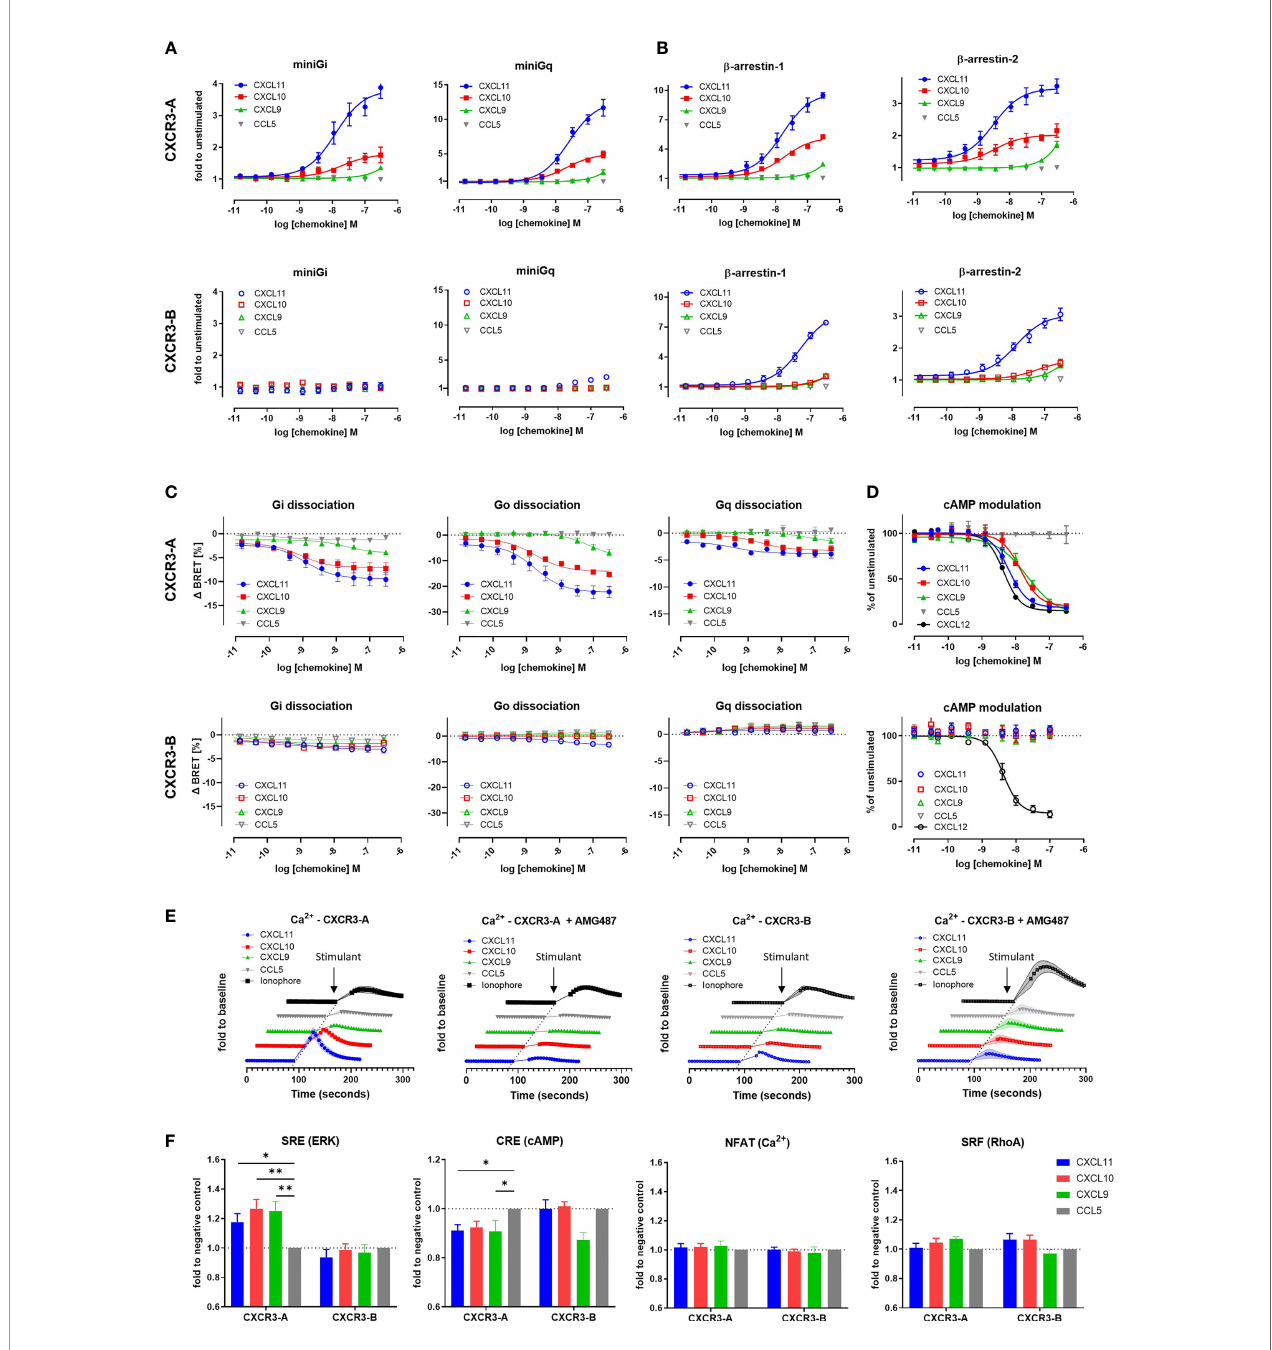
FIGURE 1 | The CXCR3-B isoform does not induce G protein-mediated signaling. (A) miniG protein or (B) b -arrestin recruitment towards CXCR3-A and CXCR3-B in response to CXCL11, CXCL10, CXCL9 and the negative control CCL5 monitored by NanoBiT-based assay. (C) Heterotrimeric G protein dissociation upon CXCR3-A or CXCR3-B stimulation with CXCL11, CXCL10, CXCL9 and CCL5 monitored by NanoBRET. Concentration-response relationships for the alpha subunits G i2 , G o and G q are expressed as D BRET. (D) CXCR3-A- and CXCR3-B-driven reduction of intracellular cAMP levels, in response to chemokine ligands. CXCL12- induced effect mediated by the endogenously expressed CXCR4 was used as positive control. (E) CXCR3-A- and CXCR3-B-mediated intracellular calcium mobilization in response to chemokines in the absence or presence of CXCR3 antagonist AMG487 (1 µM) monitored by NanoBiT assay. Calcium ionophore A23187 (1 µM) was used as receptor-independent positive control. (F) Comparison of CXCR3 isoform-mediated downstream signaling events using the nanoluciferase- dependent response elements SRE, CRE, NFAT and SRF in response to the chemokines CXCL11, CXCL10, CXCL9 and CCL5 (100 nM). All assays were conducted in HEK293T cells. Data points represent mean ± SEM of three independent experiments. *p < 0.05 and **p < 0.01 by Kruskal-Wallis with two-sided Dunn ’ s